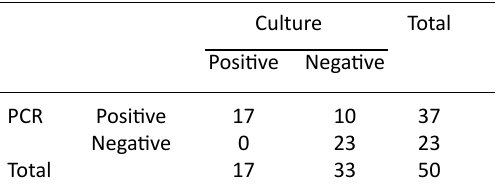
Table 4. Diagnostic accuracy of PCR v/s